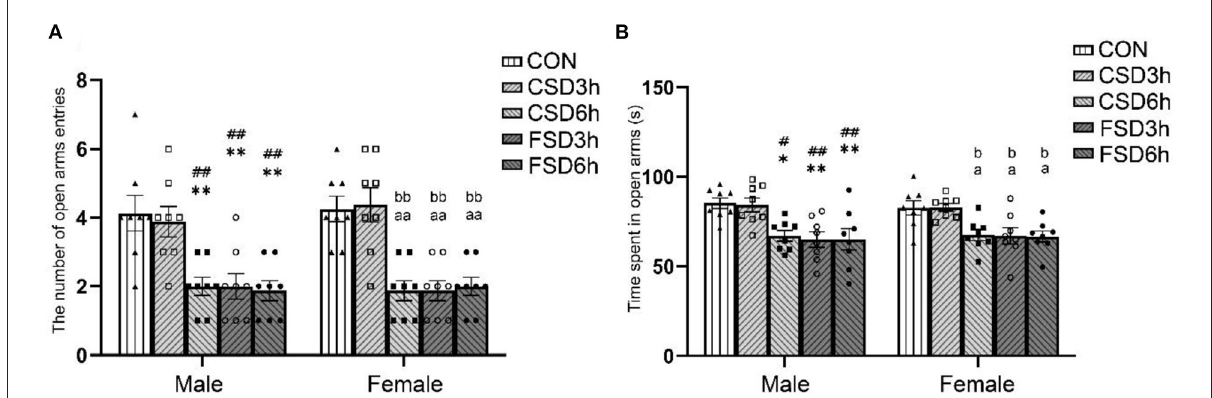
FIGURE3 Results of the elevated plus maze test (16 mice were tested per treatment group, including 8 males and 8 females). The time spent in the center and the number of open arms entries of the elevated plus maze are depicted graphically. A shorter duration in the open arms and fewer entries into the open arms were regarded as increased anxiety-like behaviors. (A) Number of entries into the open arms. (B) Time spent in the open arms. * P < 0.05 and ** P < 0.01 vs. Male CON group; # P < 0.05 and ## P < 0.01 vs. Male CSD3h group; a P < 0.05 and aa P < 0.01 vs. Female